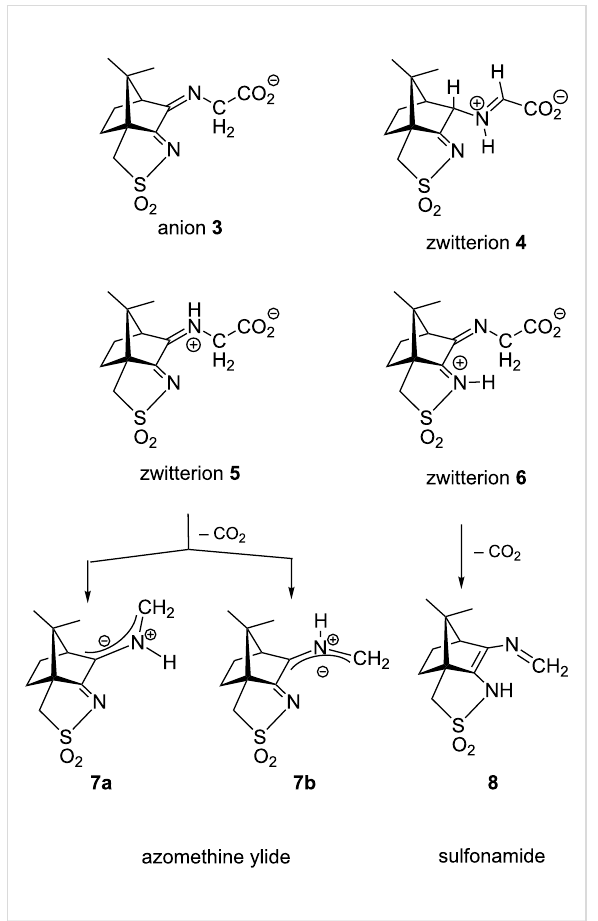
Figure 7: Upper row: anion 3 and zwitterion 4 which are stable upon geometry optimization. Middle row: zwitterions 5 and 6 which lose CO 2 upon geometry optimization. Lower row: products formed by decarbox- ylation of the